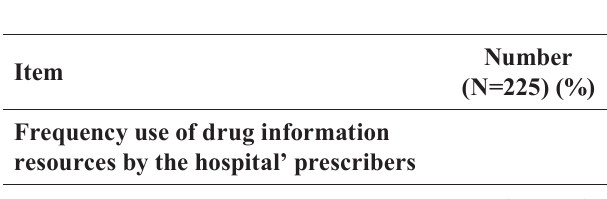
TABLE II - Drug information resources used by